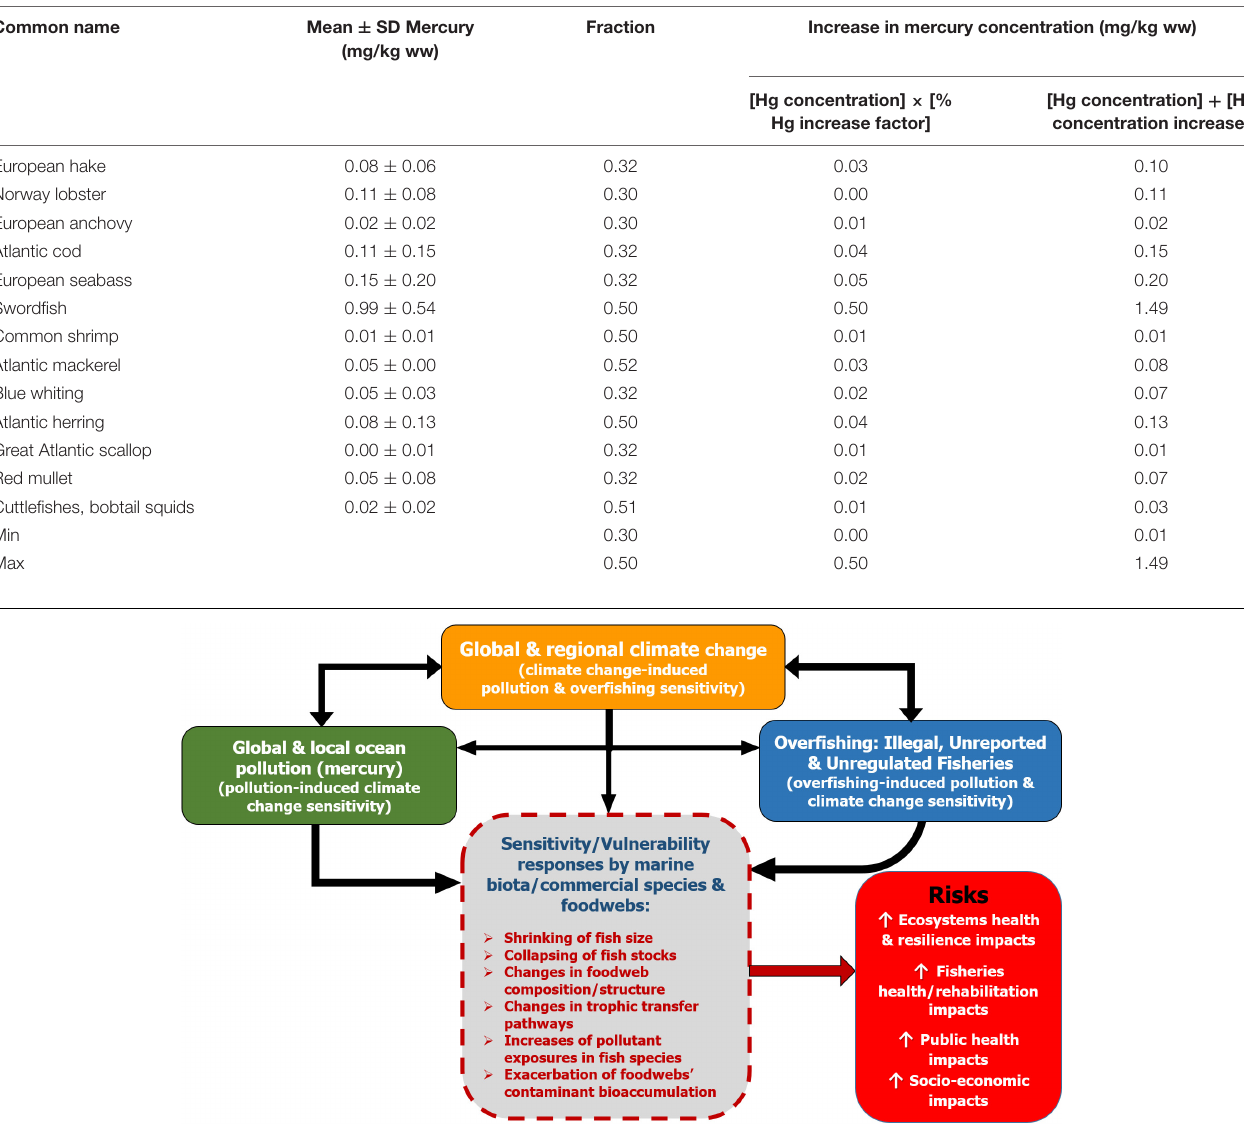
TABLE 2 | Results from the preliminary analysis of mercury levels in commercial fish and shellfish species in European waters.